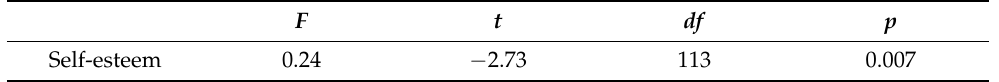
Table 4. Analysis of patients’ self-esteem using the Student t -test before and after the procedure.